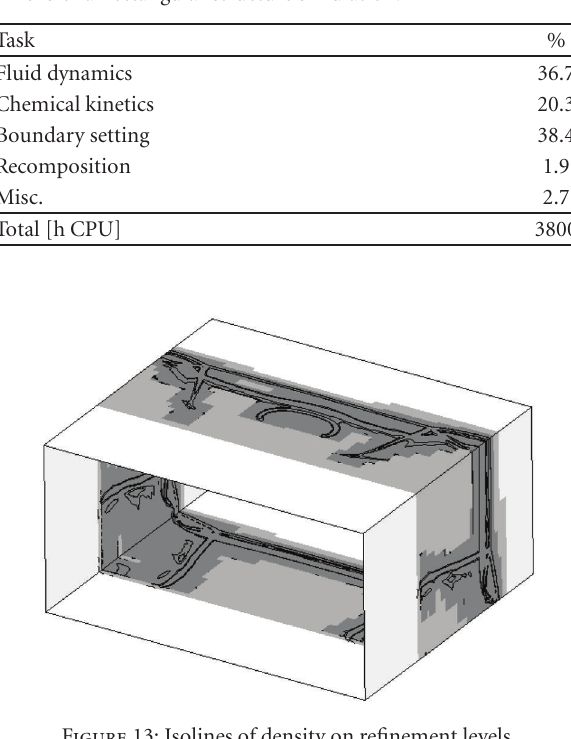
Figure 13: Isolines of density on refinement